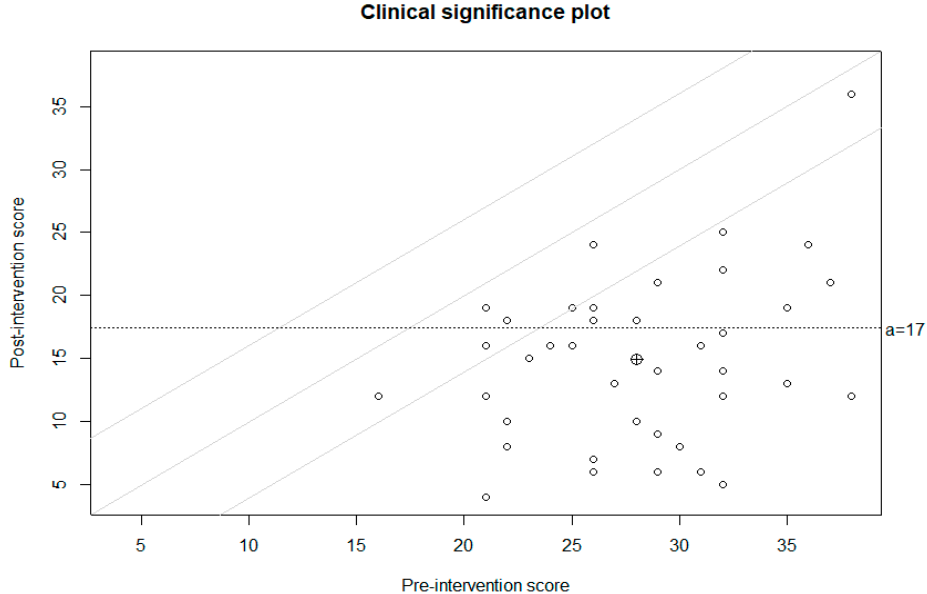
Figure 2. Reliable change index and clinical significance.